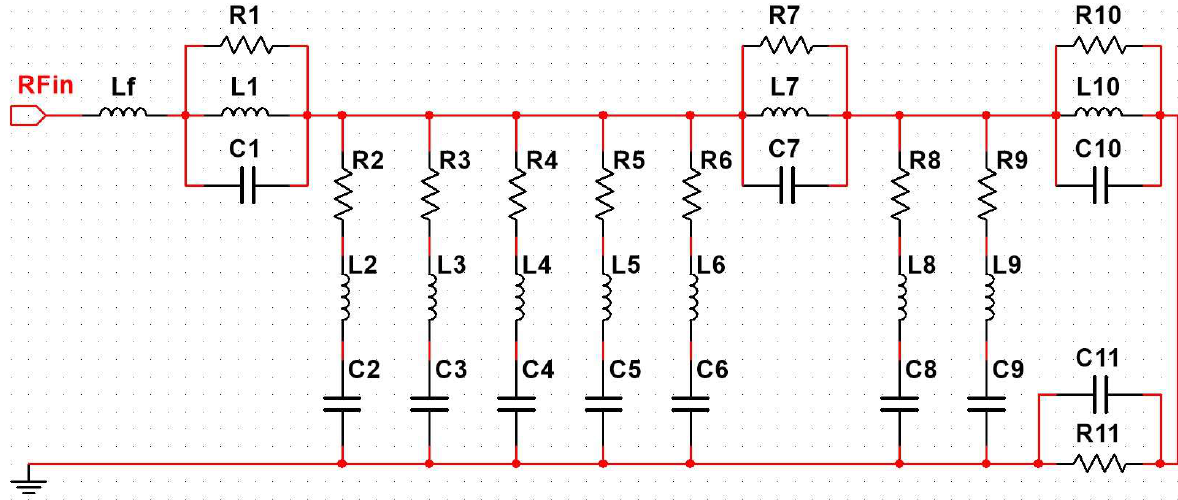
Table 3. Comparison between the simulated and calculated Q and ROC of the proposed antenna. Figure 7. Equivalent circuit model. Figure 7. Equivalent circuit model.